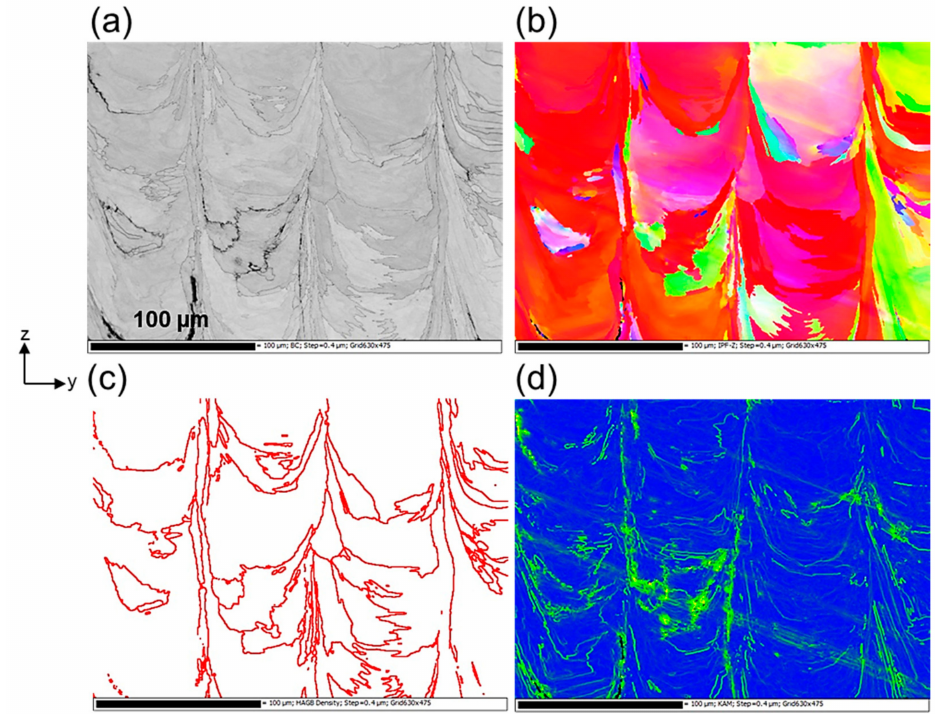
Figure 7. EBSD analysis including ( a ) BC map with corresponding ( b ) IPF map, ( c ) HAGB map, and ( d ) KAM map of as-built Cr components with short scan length